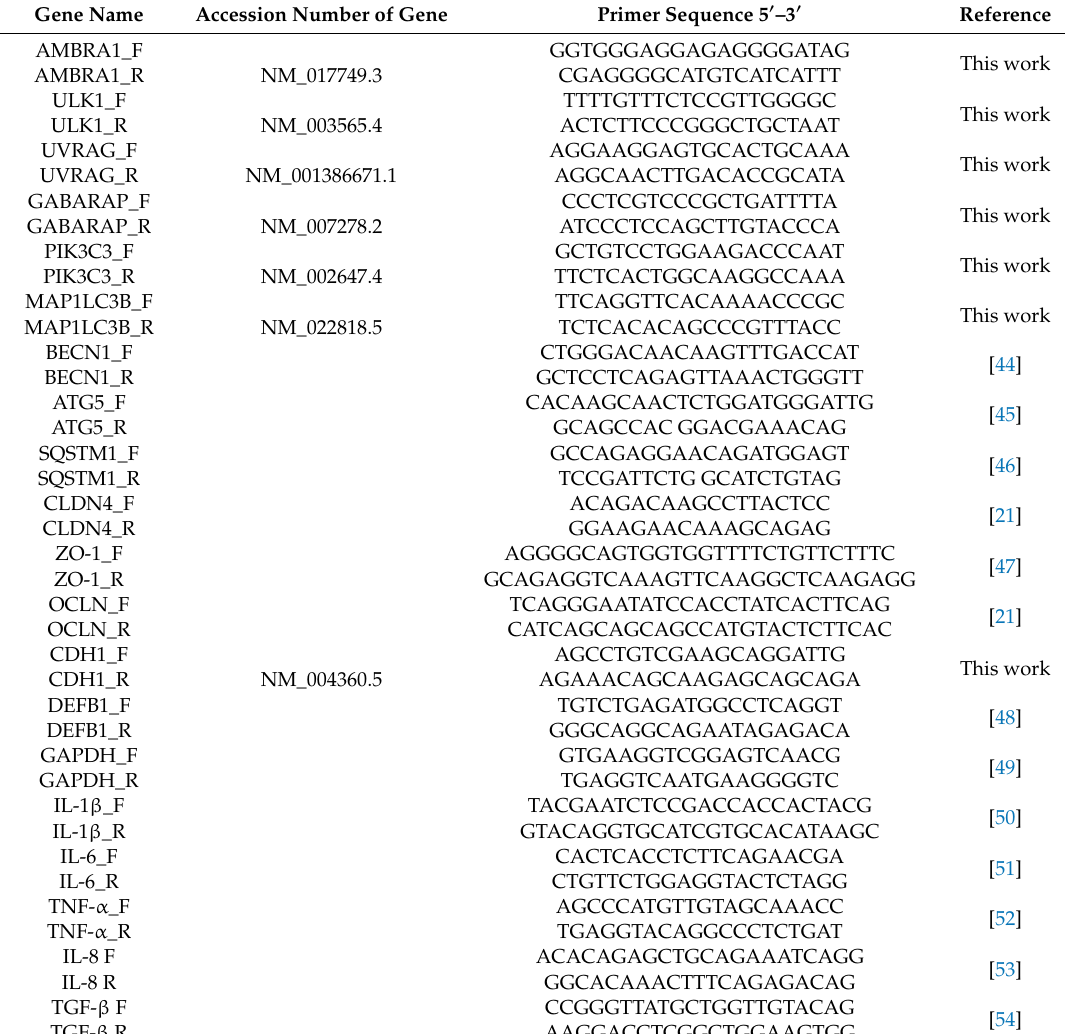
Table 1. List of Primers Used in This